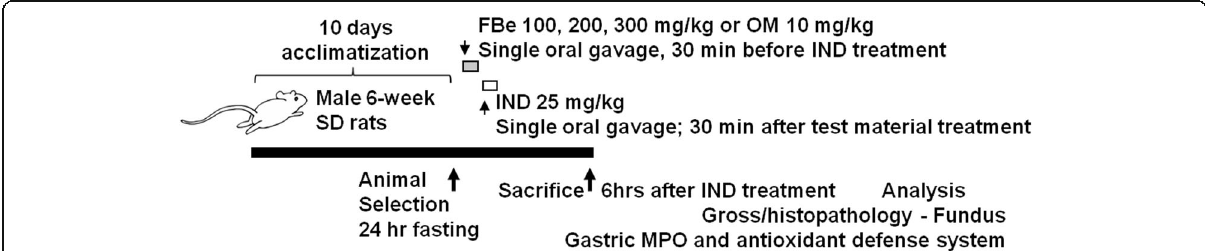
Fig. 1 Experimental designs used in this study. FBe: triple fermented barley extract as test material; IND: indomethacin; OM: